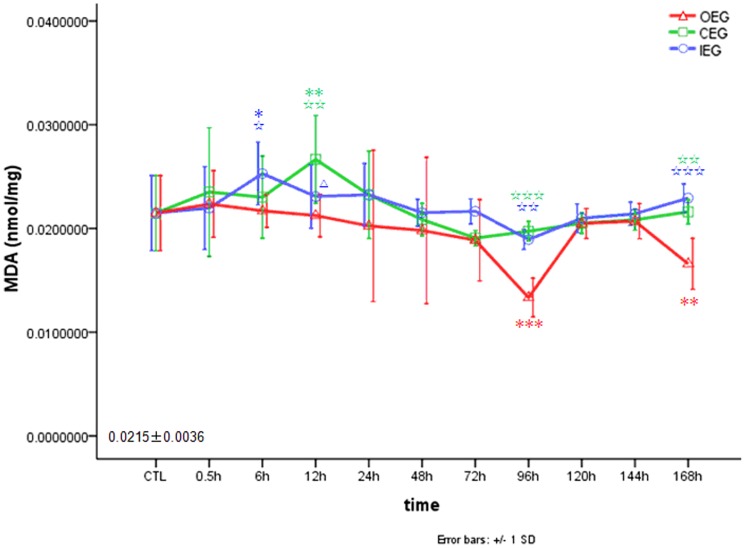
Changes in MDA in rectus femoris muscle after OE, CE, and IE.* P<0.05, ** P<0.01, *** P<0.001 vs CTL (MDACTL = 0.0215±0.0036 nmol/mg); ☆P<0.05, ☆☆P<0.01, ☆☆☆P<0.001 vs OEG; Δ P<0.05 CEG vs IEG.